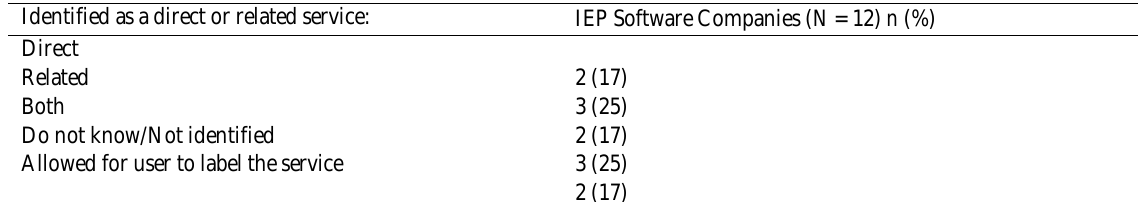
Table 5. Adapted physical education service